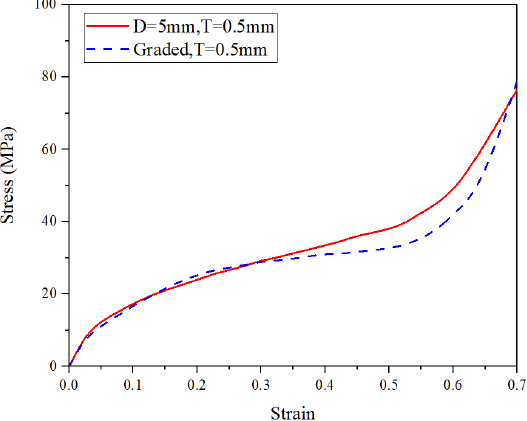
Figure 17. Stress–strain curves of the CCCFs with the same wall thickness and a different pore arrangement (i.e., the uniform and graded foam pores).